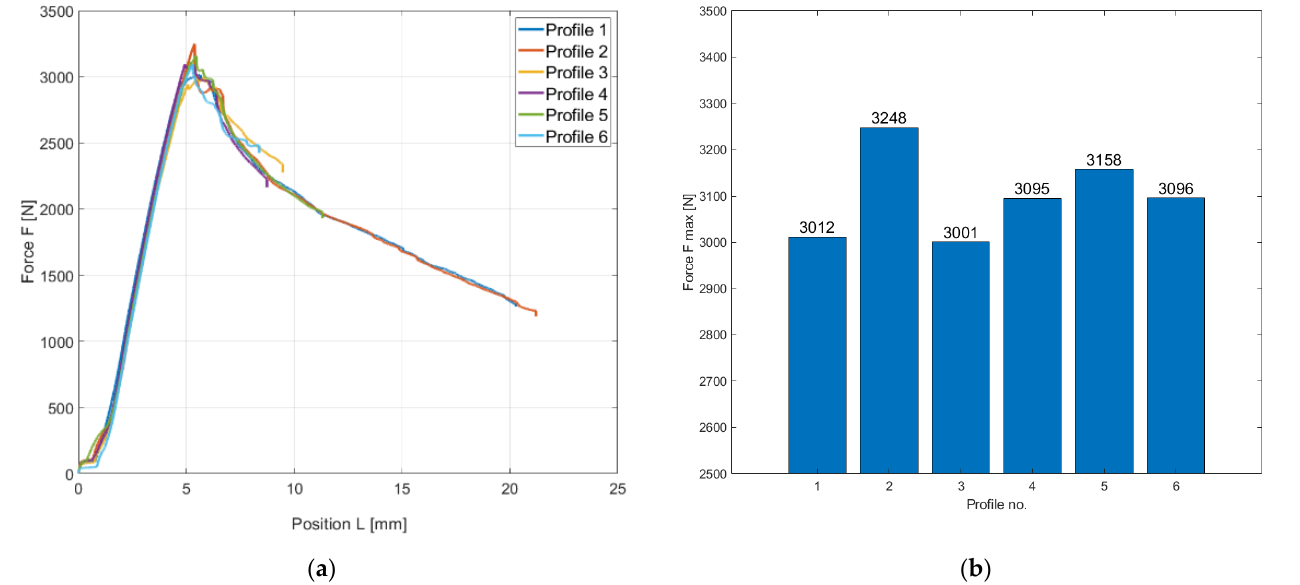
Figure 4. Graphical evaluation buckling test of CFRP profiles produced using 3D printing; ( a ) a line graph of the dependence of the maximum force on the deformation shift, ( b ) a bar graph of the achieved maximum forces for individual profiles.